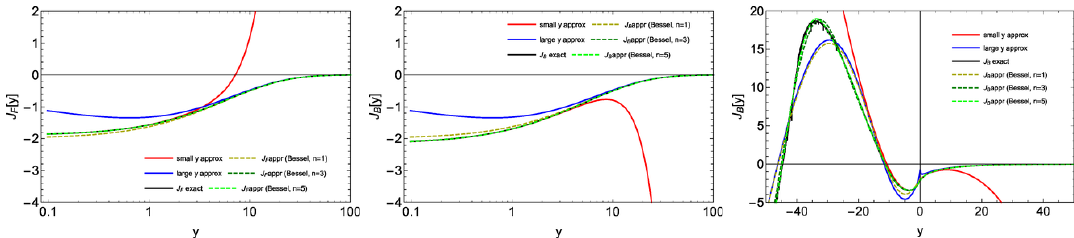
Figure 4 . Thermal function for fermionic (left) and bosonic (middle) states for positive y . For bosonic states, we additionally present the negative y range since their thermal mass can be negative at T 6 = 0. In each plot the result of the exact integral is shown in solid black curve. Red and blue curves give the small and large y approximations, respectively. Three dashed lines illustrates the result evaluated by summing over the Bessel functions at di(cid:11)erent